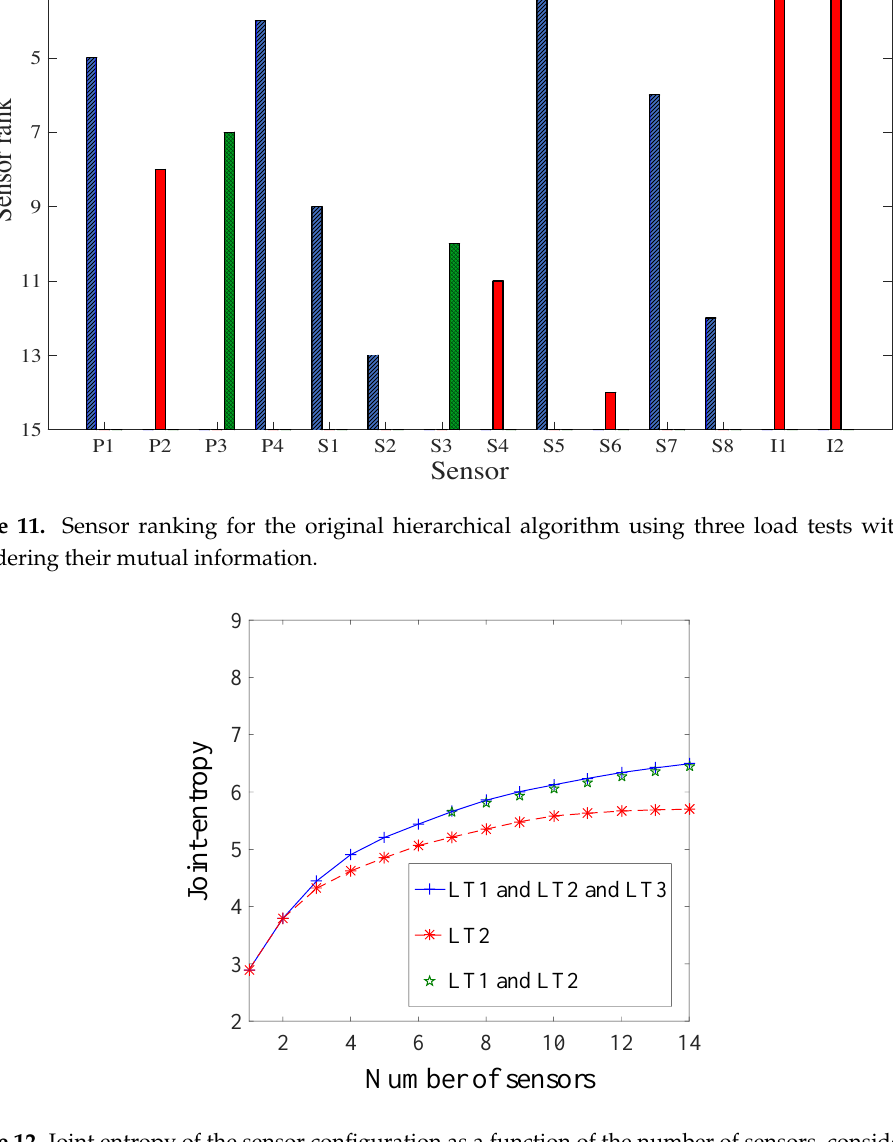
Figure 12. Joint entropy of the sensor configuration as a function of the number of sensors, considering successively the original algorithm for LT2; LT1 and LT2; and all three load tests.